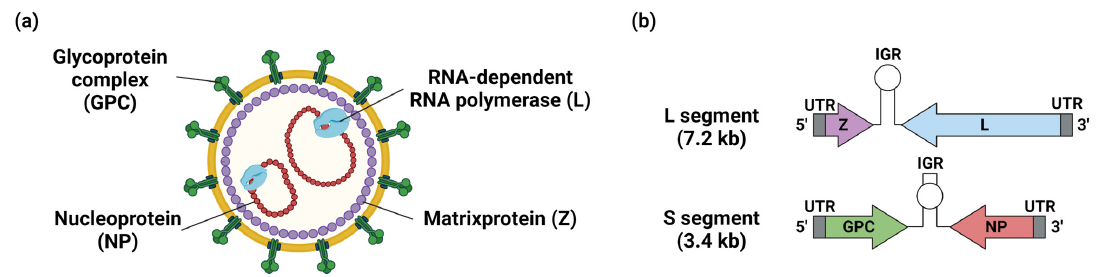
Figure 3. Structure of arenavirus virion and genome. ( a ) Structure of arenavirus virion showing surface glycoprotein complex (GPC,), nucleoprotein (NP), Zinc finger matrix protein (Z), and RNA- dependent RNA polymerase (L). ( b ) The genome of arenaviruses is bi-segmented, single-stranded, negative-sense RNA. The segmented genomes consist of small- (S) and large (L)-segments flanked by 5 ′ untranslated regions (UTRs) and 3 ′ UTRs. The L segment encodes Z and L, and the S segment encodes GPC and NP. The S- and L-segment encode their respective proteins using an ambisense encoding strategy, with the coding regions separated by the noncoding intergenic regions (IGRs). Figure created with BioRender (https://app.biorender.com, (accessed on 9 March